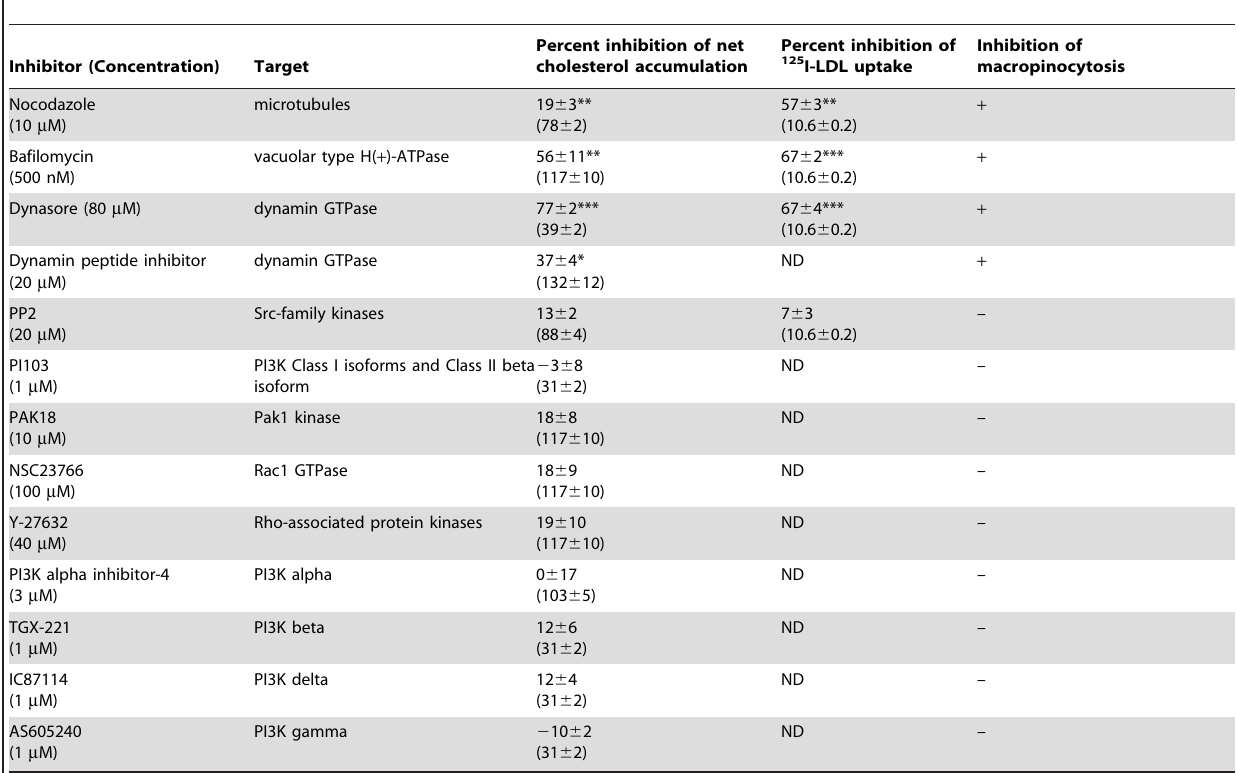
Table 3. The effect of possible inhibitors of fluid-phase pinocytosis on LDL uptake and net cholesterol accumulation in wild-type M-CSF-differentiated